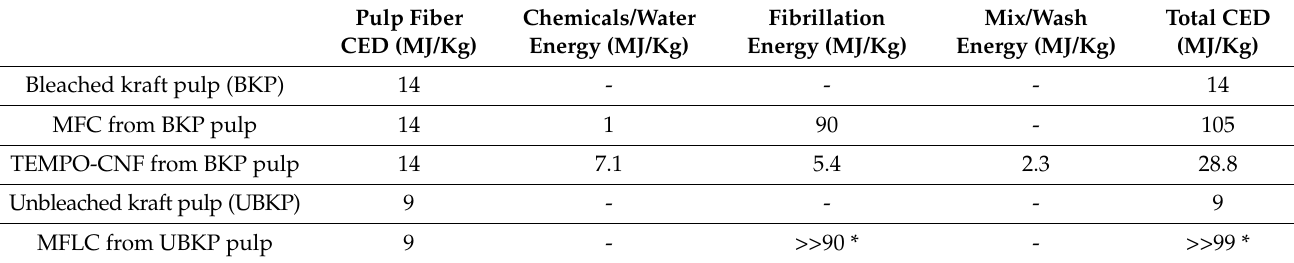
Cumulative energy demand of wood fibers and MFC/CNF at “industrial scale” fabrication (see supporting